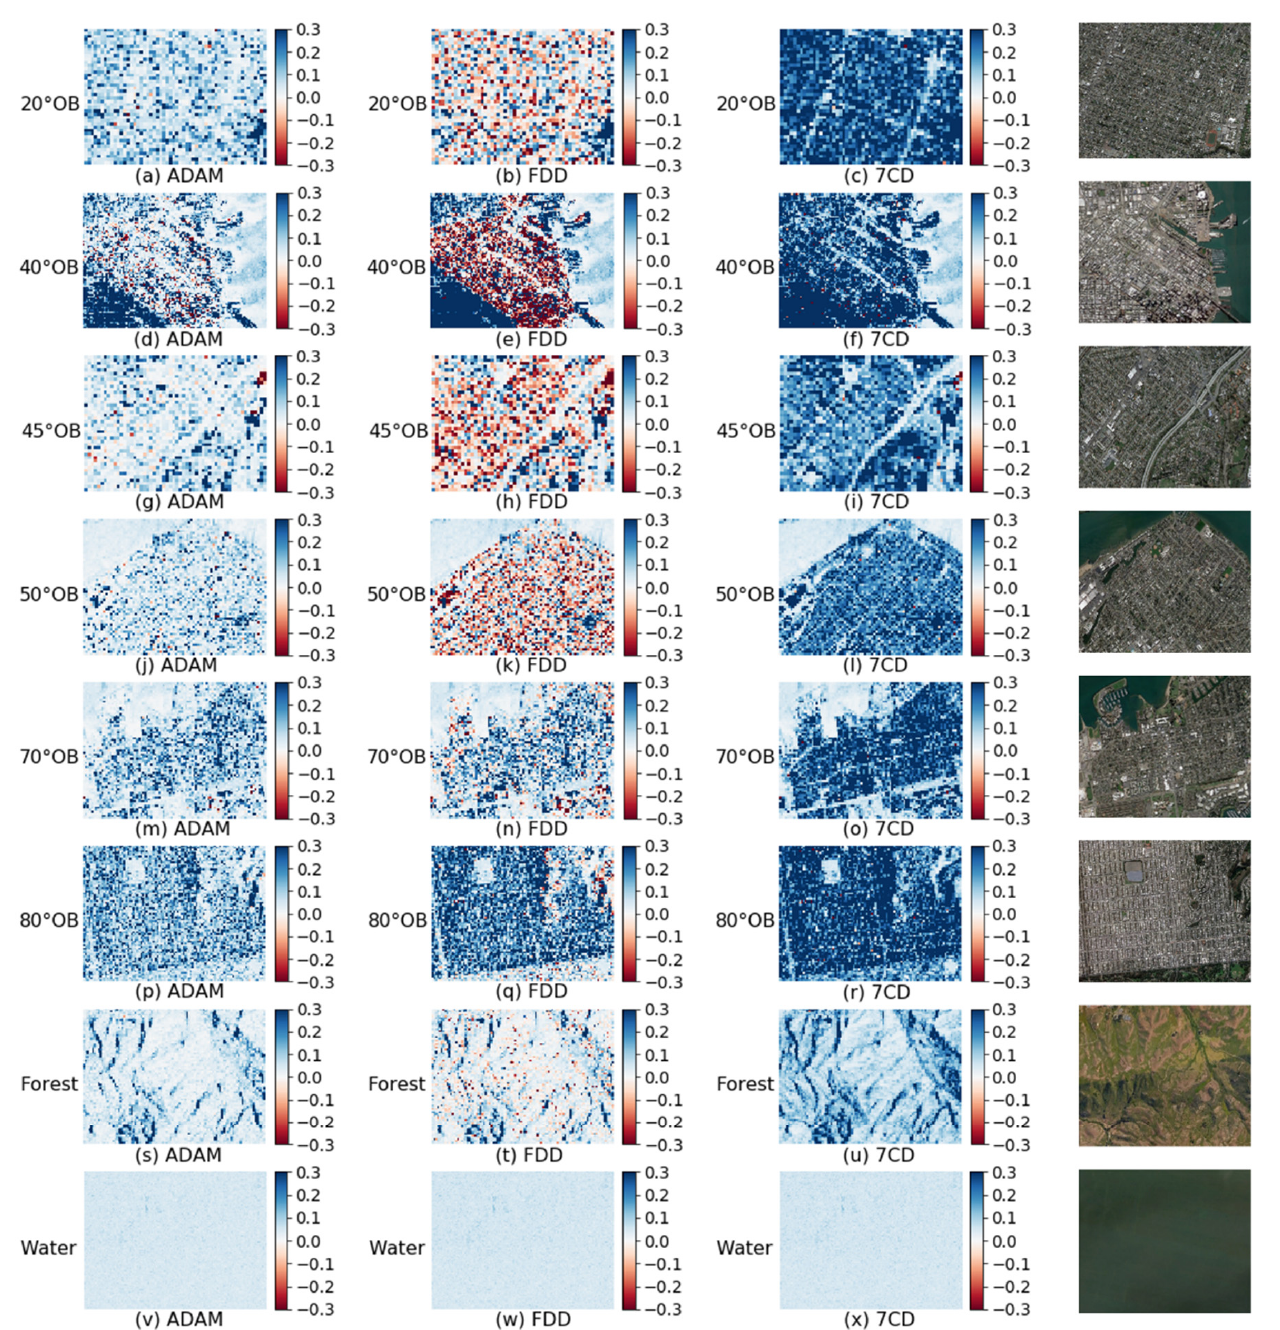
Figure 13. The output map of surface scattering power P s estimated by ADAM, FDD, and 7CD for 8 types of samples over San Francisco, USA.